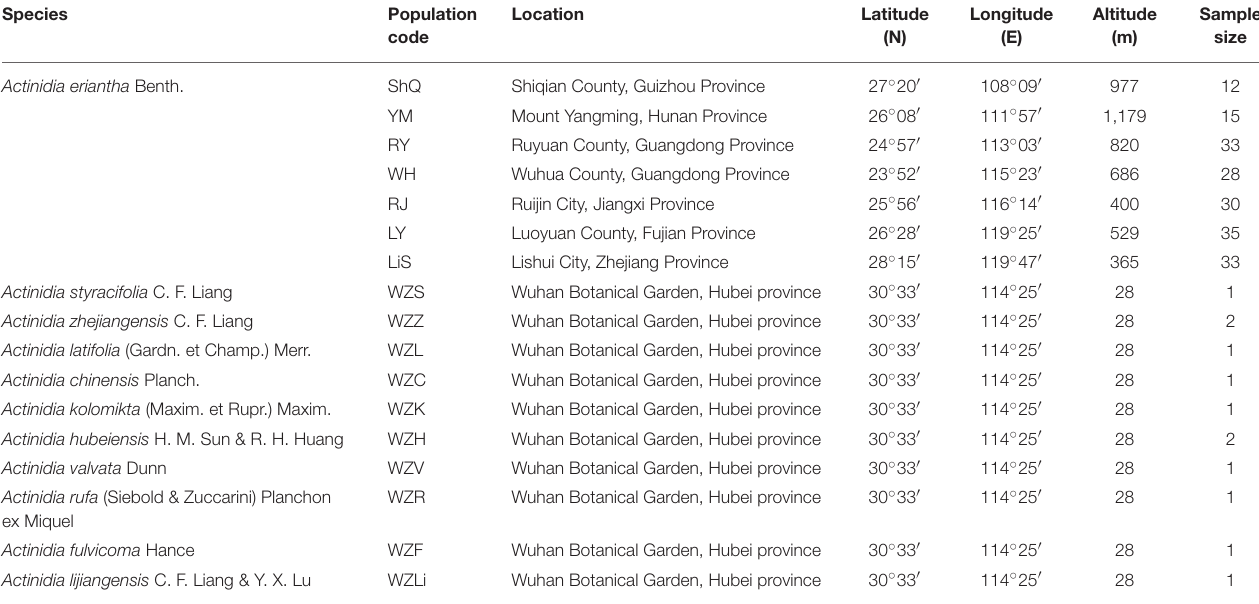
Location Latitude code